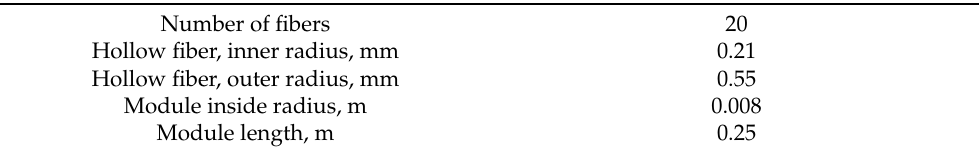
Table 1. Membrane characteristics used in the mathematical model at room temperature and ambi- ent